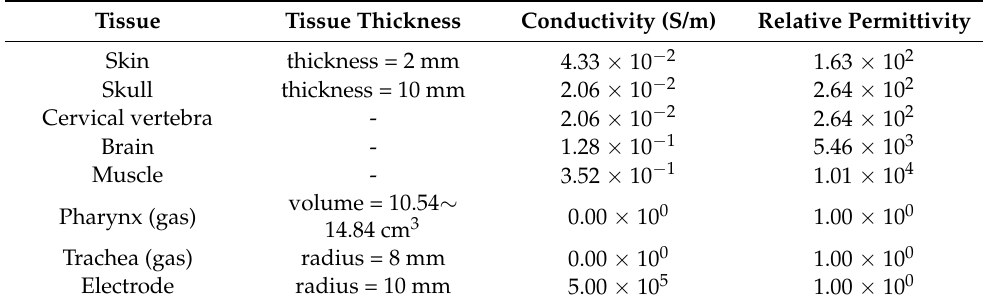
Table 1. Parameters of simulation